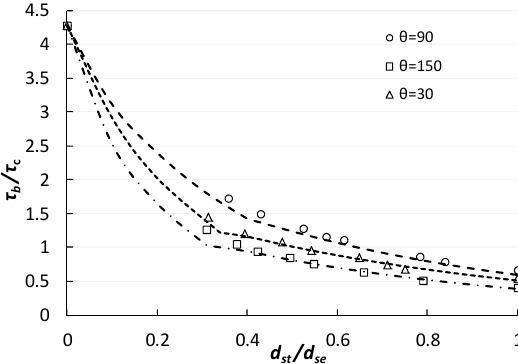
Figure 8. The trend of local bed shear stress evolution.